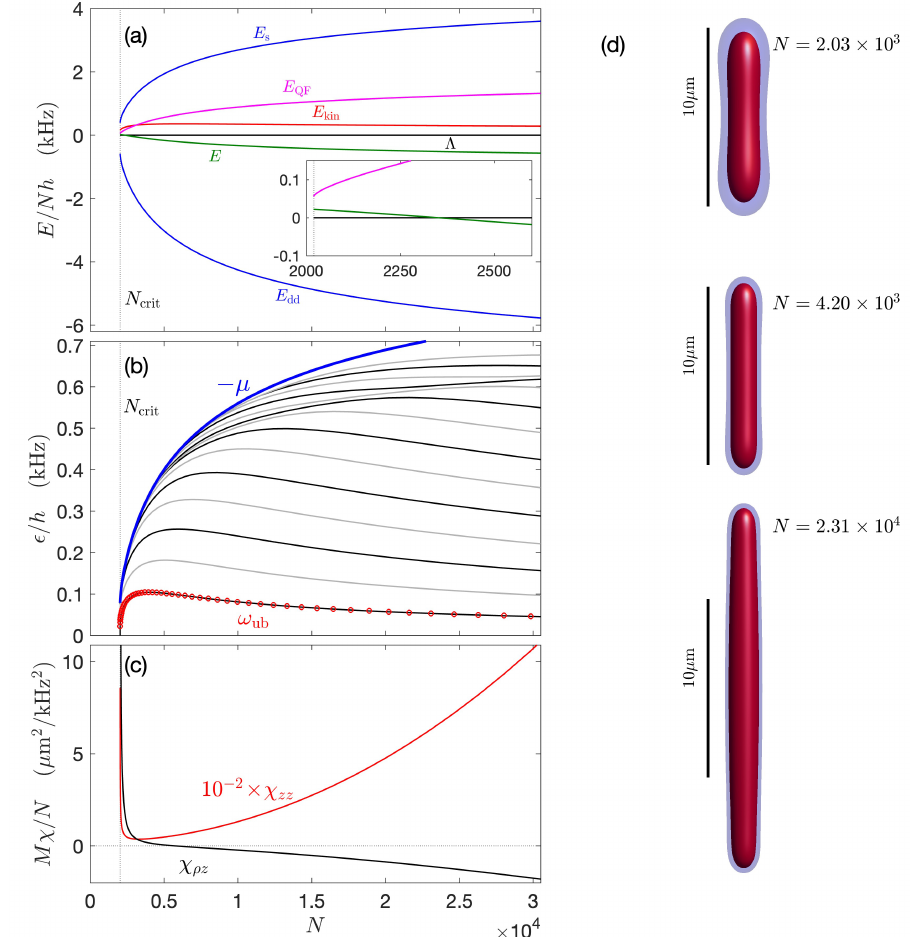
Figure 1. Free-space droplet ( V = 0) as a function of atom number N . ( a ) Components of energy and the virial Λ . The inset shows a zoom in close to N crit ≈ 2020 to reveal where the total energy is positive. ( b ) The results from the numerical solution of the BdG equations for the m = 0 excitations that are even (black lines) and odd (grey lines) with respect to a reflection along z through the droplet center. The approximate result ω ub obtained from (15) is shown in red circles. The droplet binding energy, characterized by − µ , is shown for reference (blue line). ( c ) The static polarizabilities χ zz and χ ρ z . Results are for 164 Dy using a dd = 130.8 a 0 and a s = 80 a 0 . ( d ) Density isosurfaces of droplet states for various N values as labeled. Isosurfaces shown for 10 18 m − 3 (blue) and 10 19 m − 3